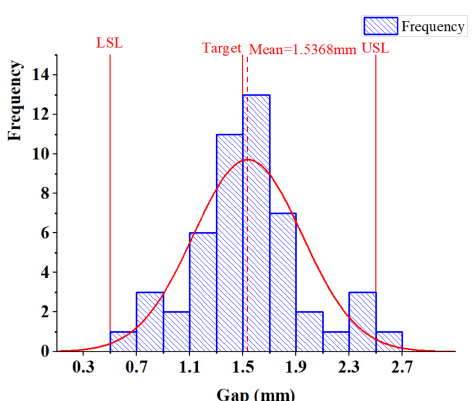
Figure 10. Histogram of the gap measurements between the tail- light and